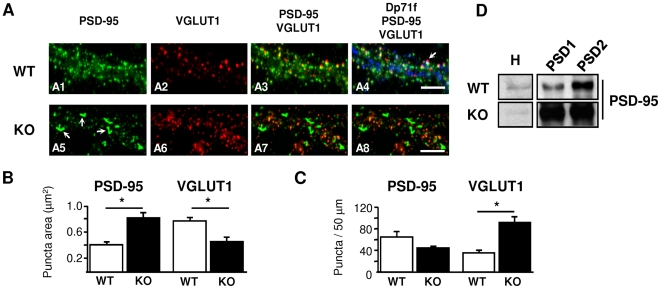
Dp71 loss alters the organization of glutamatergic synapses in vitro.A. Triple-immunofluorescence staining of dendrite segments from mature cultured neurons of WT (Top) and KO mice (Bottom), using antibodies directed against PSD-95 (green, A1, A5), VGLUT1 (red, A2, A6), and Dp71 (blue on overlay in A4). Dp71-deficient neurons show abnormally larger PSD-95 clusters on excitatory synapses (arrows in A5), a scarcity of synapses double-stained for PSD95 and VGLUT1 (A7) compared to controls (A3). Dp71 clusters positive for both PSD95 and VGLUT1 were present in WT neurons only (arrow in A4). Scale bars, 10 µm. B–C. Quantitative analyses of PSD-95 and VGLUT1 clusters. Histograms show the size of the clusters (B, puncta area) and the number of clusters per 50-µm dendritic length (C, puncta/50 µm), in WT (white) versus Dp71-null neurons (black). *p<0.001. D. Immunoblot analysis of PSD95 expression in total homogenate (H) and postsynaptic density fractions (PSD1, PSD2) from WT and KO mouse brain extracts (n = 15 mice per genotype distributed in three independent immunoblots).